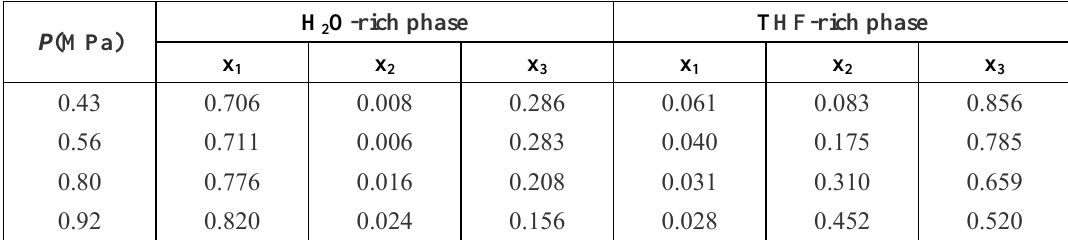
O(1)/propane(2)/ THF(3) OATS at 30 °C [15]. 2